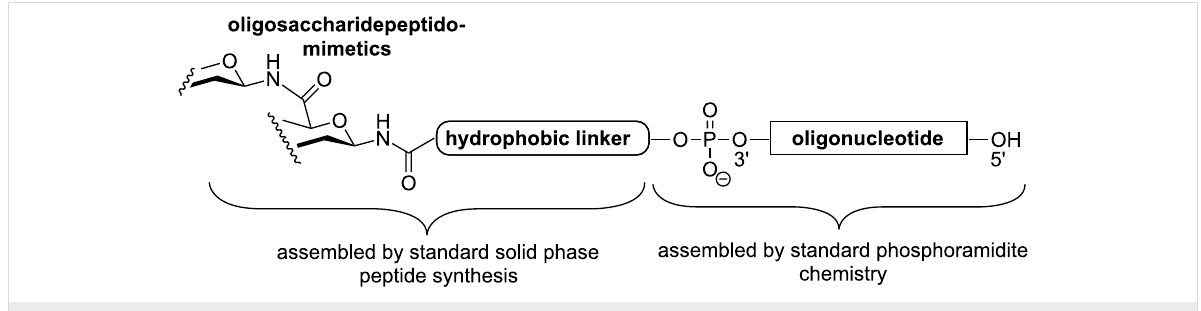
Figure 9: General structure of carbopeptoid-oligonucleotide conjugates.